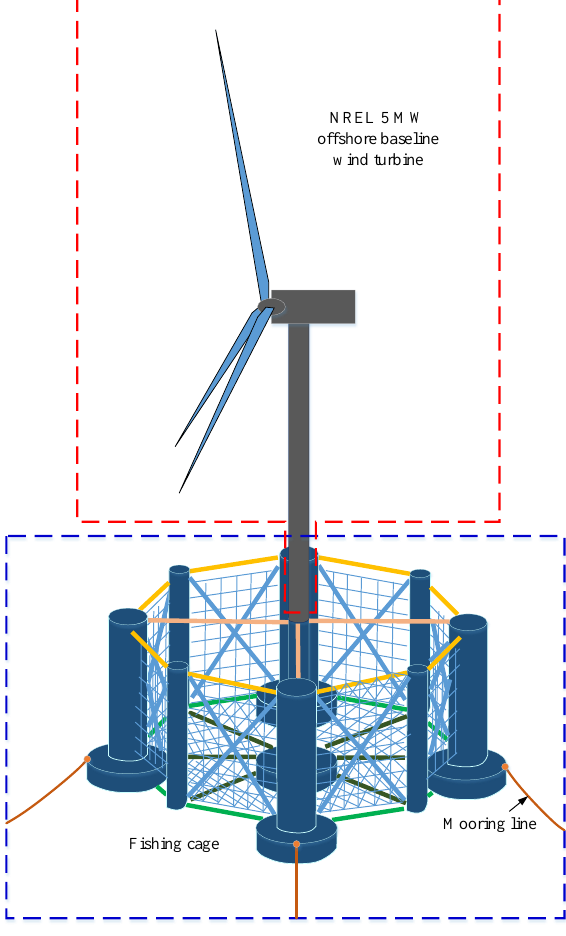
Figure 2. Schematic diagram of the integrated system of a floating offshore wind turbine and a fishing cage.